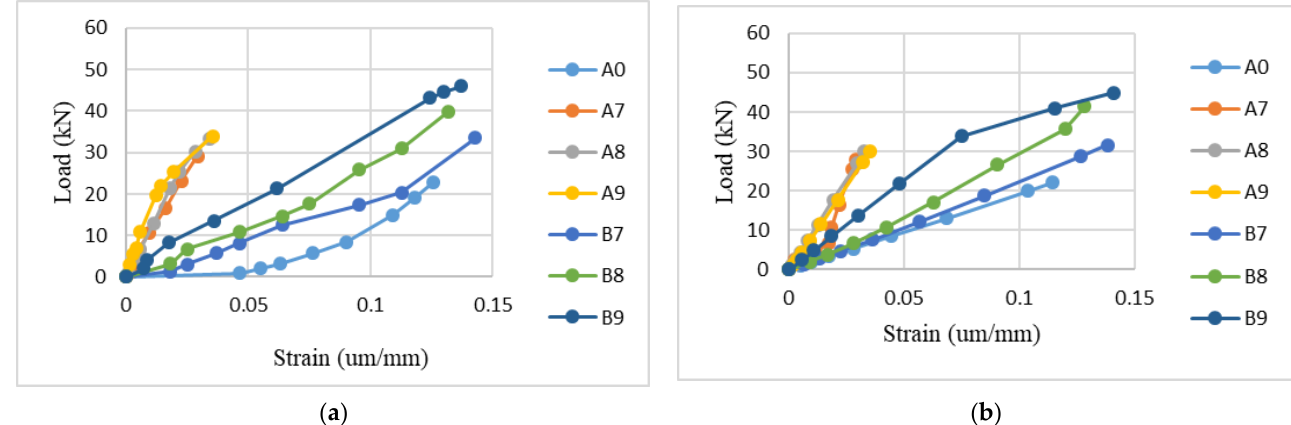
Figure 11. Strain comparison for failure load of circular and square pothole patching with asphalt and steel fiber at the interface joint. ( a ): Experimental results. ( b ): Numerical simulation results.